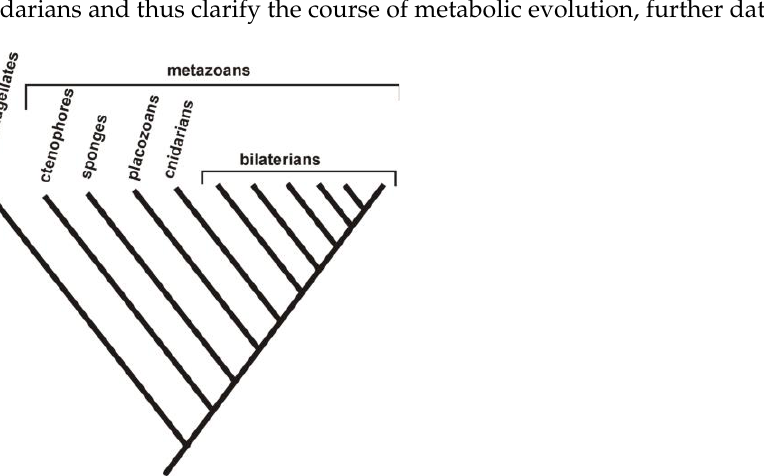
Figure 3. The five early-diverging groups of metazoans: ctenophores, sponges, placozoans, cnidarians, and bilaterians. The order of divergence is subject to considerable debate [32]. Choanoflagellates represent the sister group to Metazoa.